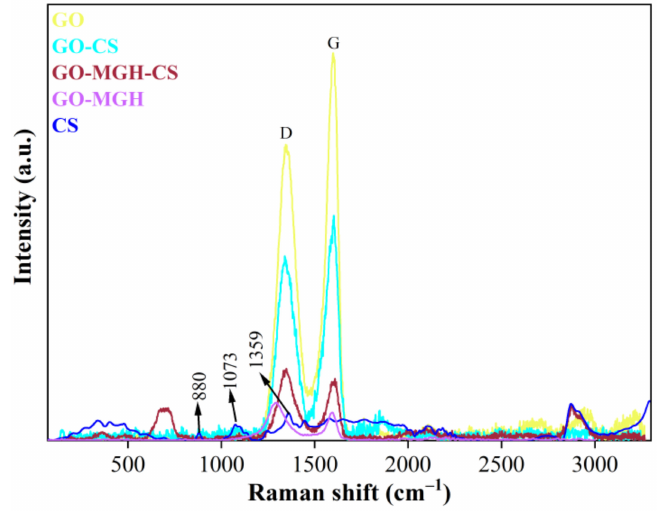
Figure 4. The Raman spectrum of GO, GO-CS, GO-MGH-CS, GO-MGH, and CS.